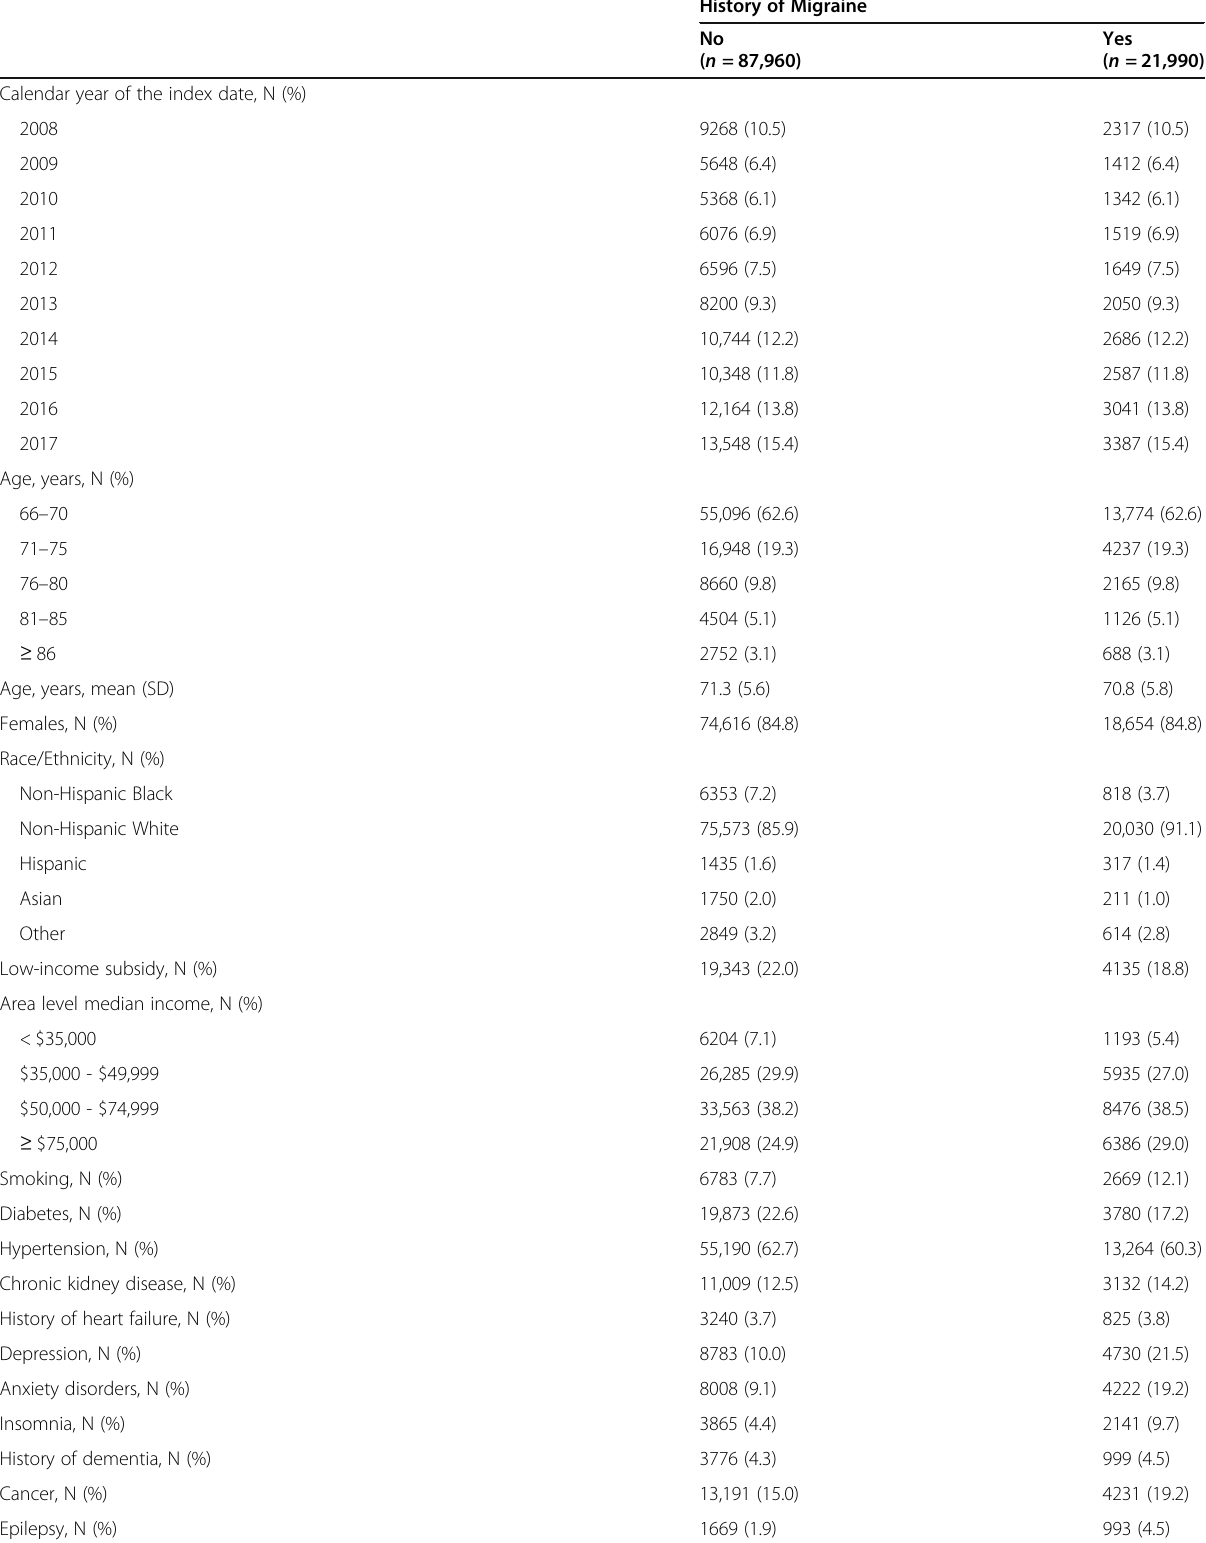
Table 1 Characteristics of patients without a history of cardiovascular disease who had and did not have a history of